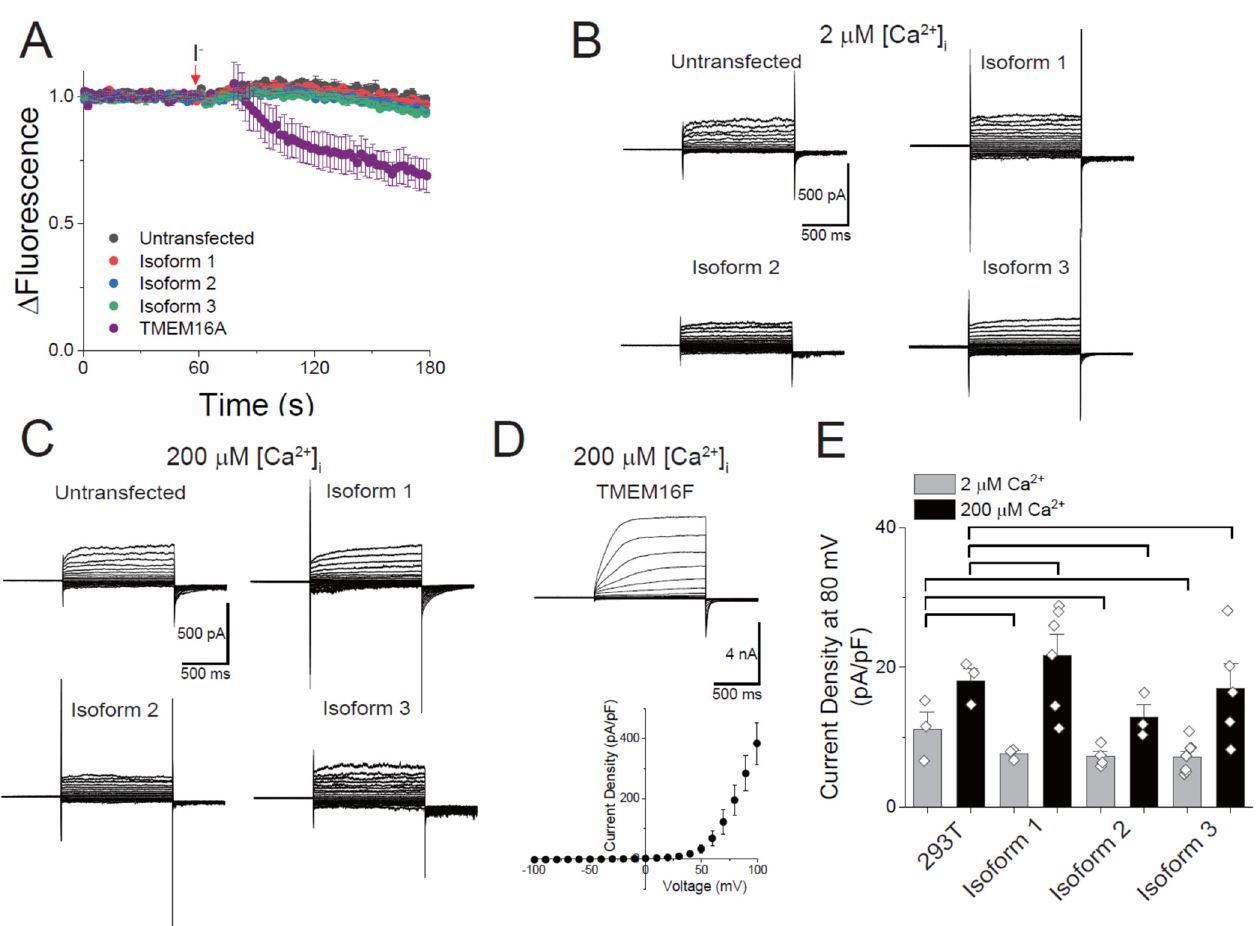
Figure 5. Ion-transporting activity of human TMEM16C isoforms. ( A ) Measurement of ion-transporting activity using an iodide-quenching assay. Each TMEM16C isoform and human TMEM16A were transfected into 293T cells stably expressing YFP-H148Q/I152L. Mean + SEM; n = 3. ( B , C ) Representative whole-cell current recordings of cells transiently transfected with human TMEM16C isoforms. 2 µ M ( B ) and 200 µ M ( C ) intracellular Ca 2+ was added and ionic currents were evoked with voltage steps ranging from − 100 mV to +100 mV in 10 mV increments. ( D ) Whole-cell recording of human TMEM16F expressing cells. The macroscopic current was measured in the presence of 200 µ M intracellular Ca 2+ (upper). The representative I-V relationship of TMEM16F (lower). ( E ) Average current densities in untransfected and TMEM16C isoform-transfected 293T cells. Current density was measured at +80 mV. Data are plotted as mean + SEM (n =